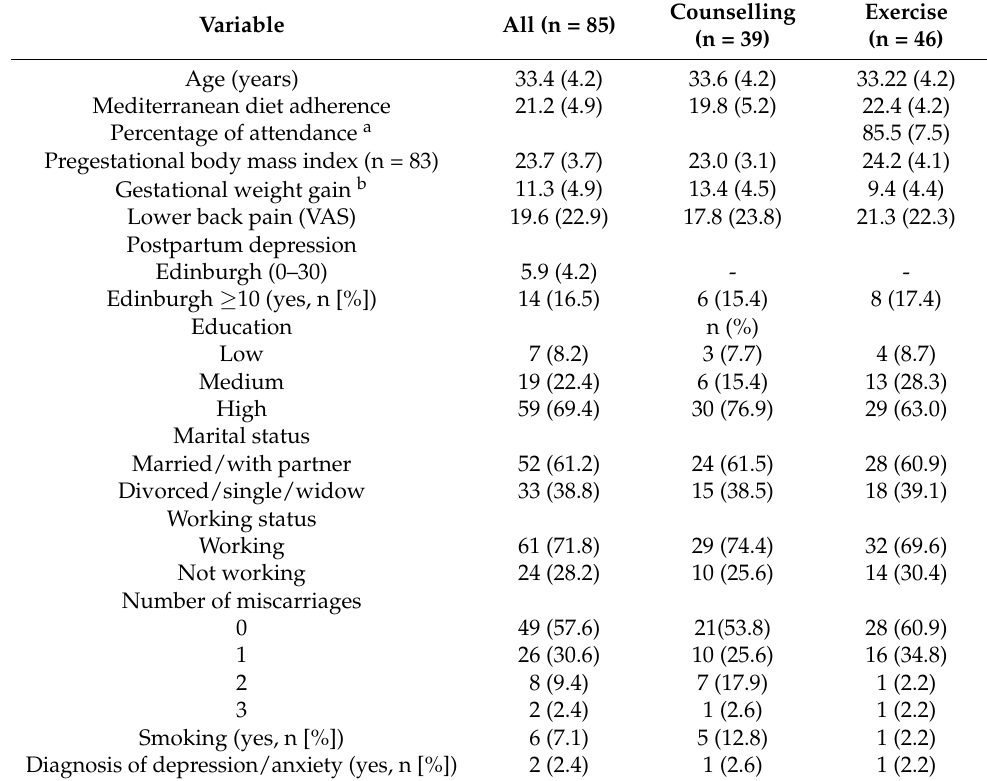
Table 1. Sociodemographic characteristics of the study participants.